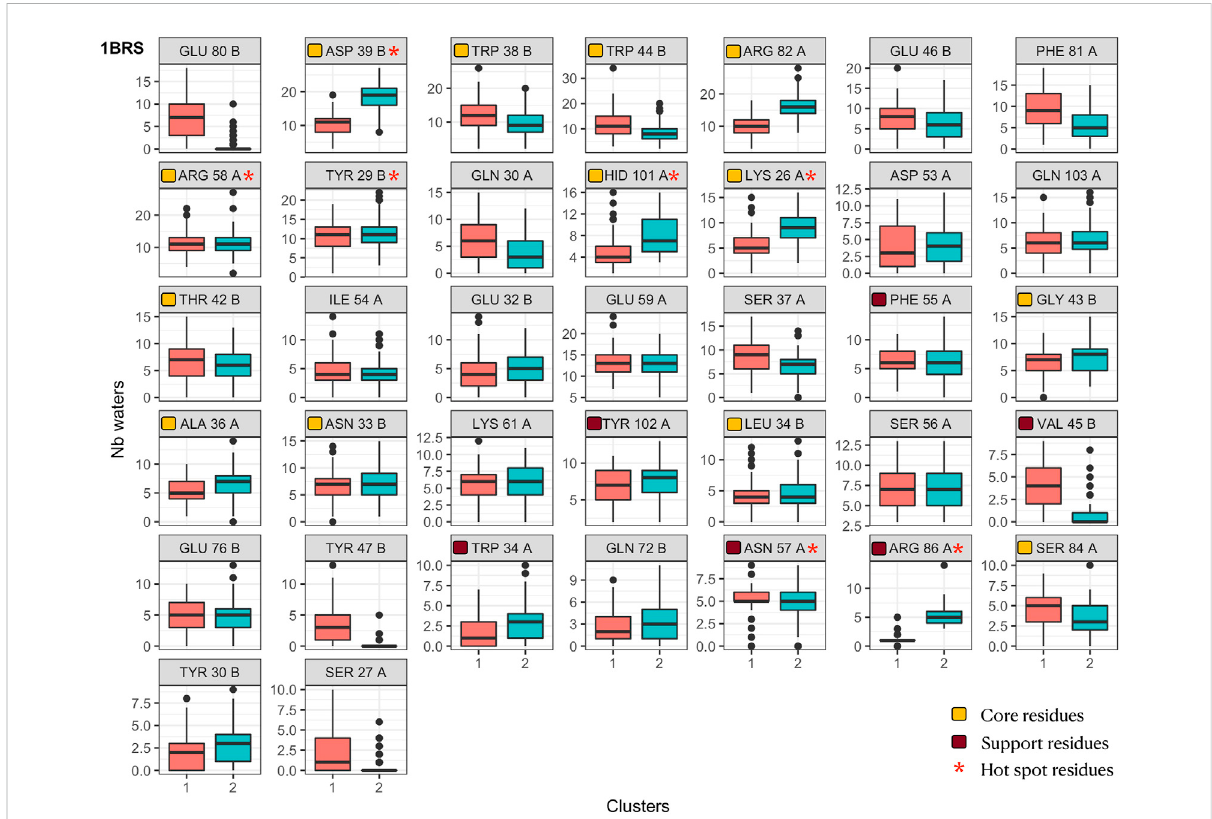
FIGURE 9 Number of interface water molecules in contact with each interface residue in the barnase/barstar complex 1BRS. Distributions are shown as boxplot in each interface cluster. Orange squares indicate core residues and brown squares indicate support residues (in X-ray structures), as in Figure 6. Red stars indicate hotspot